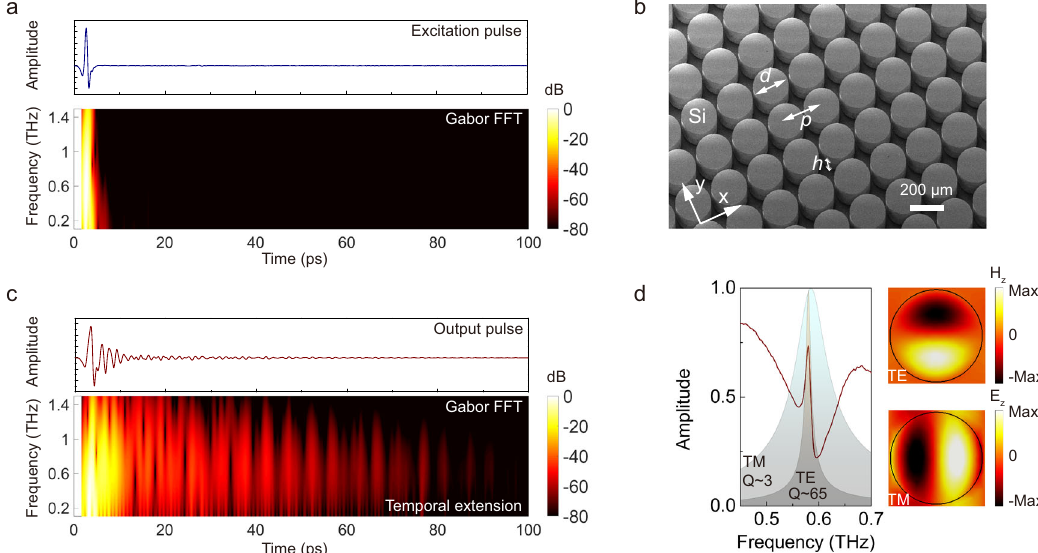
Fig. 2 Experiments with terahertz spectroscopy. a Temporal pro fi le of probe pulse and its Gabor transform pro fi le indicating the concentration of frequency components within ~5 ps. b SEM image of the metamaterial whose constituents are periodic silicon cylindrical resonators with geometric parameters d = 206 μ m, p = 225 μ m, and h = 120 μ m. c Output temporal pro fi le after transmitting through the cavity showing the long-lasting oscillations for ~100 ps. The Gabor transform reveals the elongated frequency components centered at ~0.6 THz. d The frequency spectrum of the cavity after Fourier transform containing degenerate TE and TM modes that are spatiospectrally inseparable. Mode pro fi les indicate the transverse electric and transverse magnetic features in the z-cut